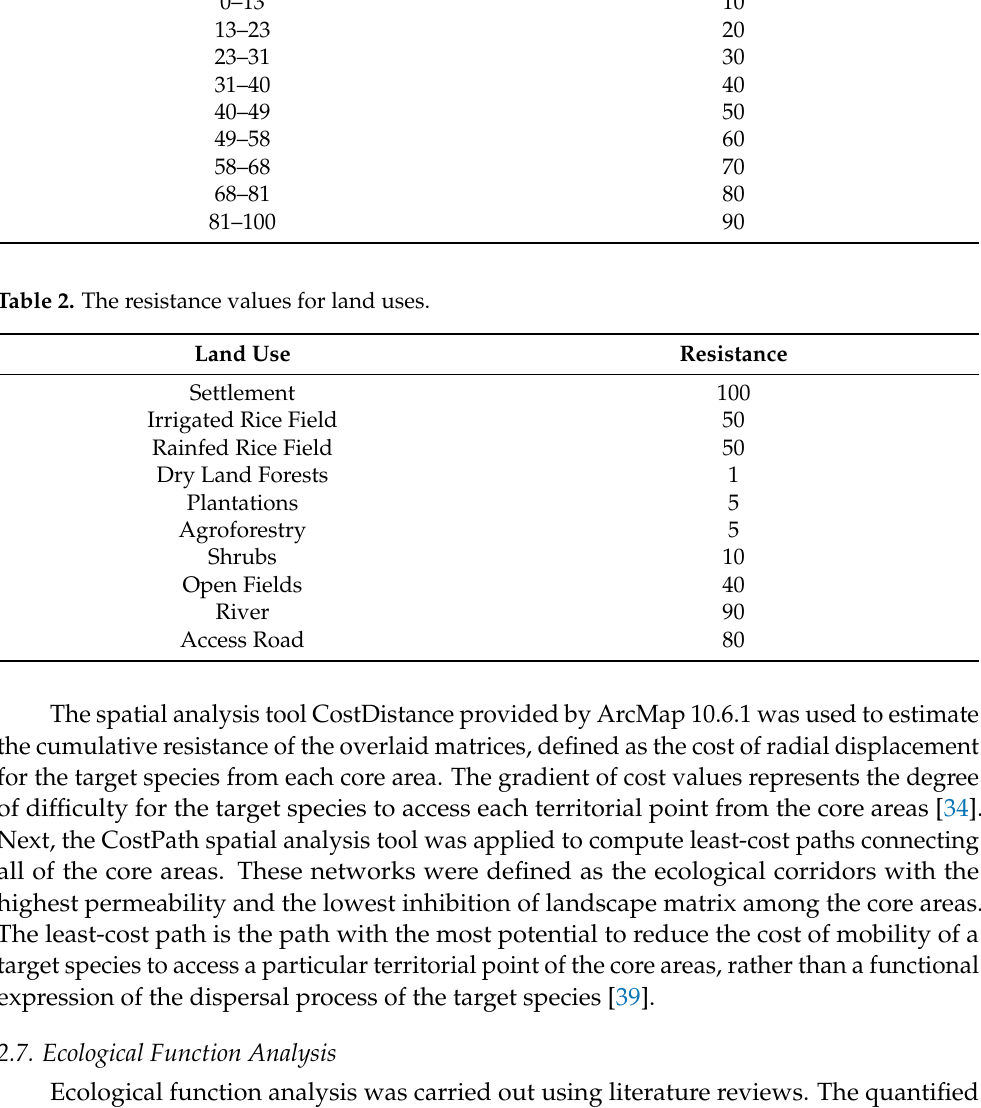
Table 1. The slope resistance values. Slope Gradient (%)